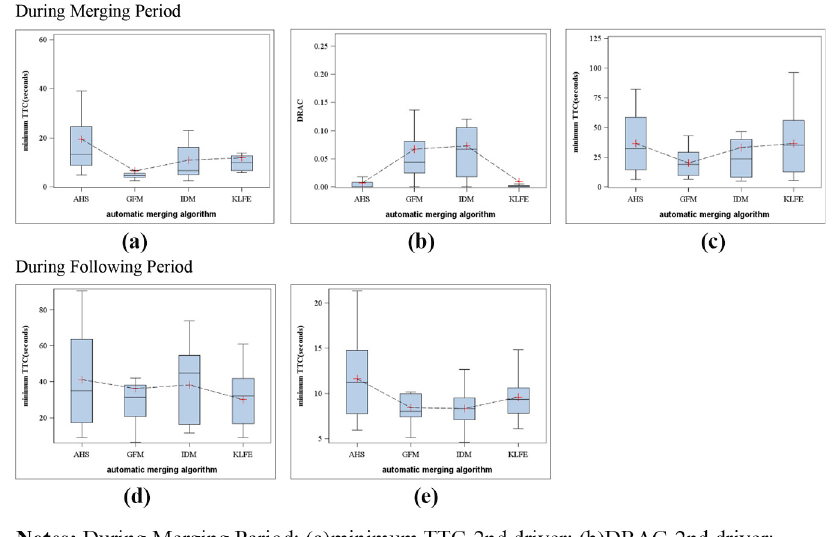
Figure 7 Driving safety level of automatic merging